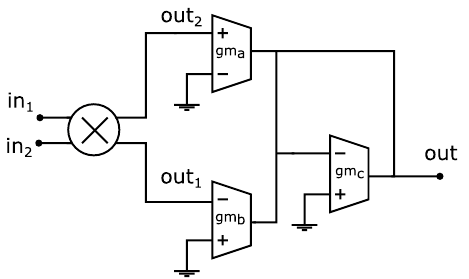
Figure 12. Multiplication of two signals using the CMOS design from Figure 11.